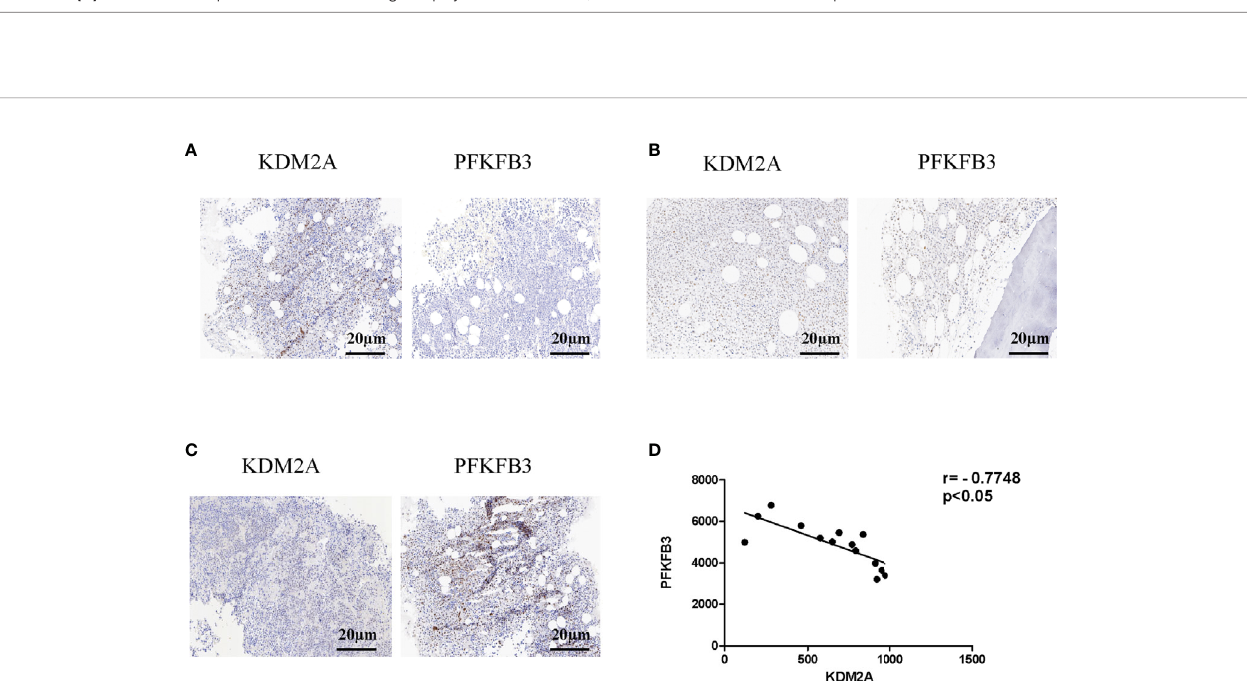
FIGURE 6 | Protein levels of KDM2A and PFKFB3 are negatively correlated in multiple myeloma patients. (A-C) Representative images of staining with KDM2A antibodies in MM patients ’ BM tissues showed strong (A) , moderate (B) , and weak (C) expression, respectively, and the expression of PFKFB3 is just the opposite of KDM2A (scale bar, 20 µm). (D) Pearson correlative analysis of semi-quantitative IOD values for KDM2A and PFKFB3 indicates that protein levels of KDM2A and PFKFB3 are negatively correlated in MM